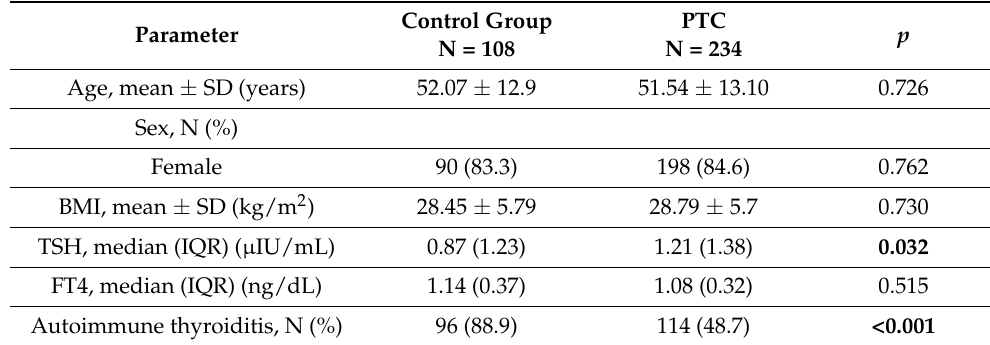
Table 1. Clinical and laboratory characteristics of the study population.